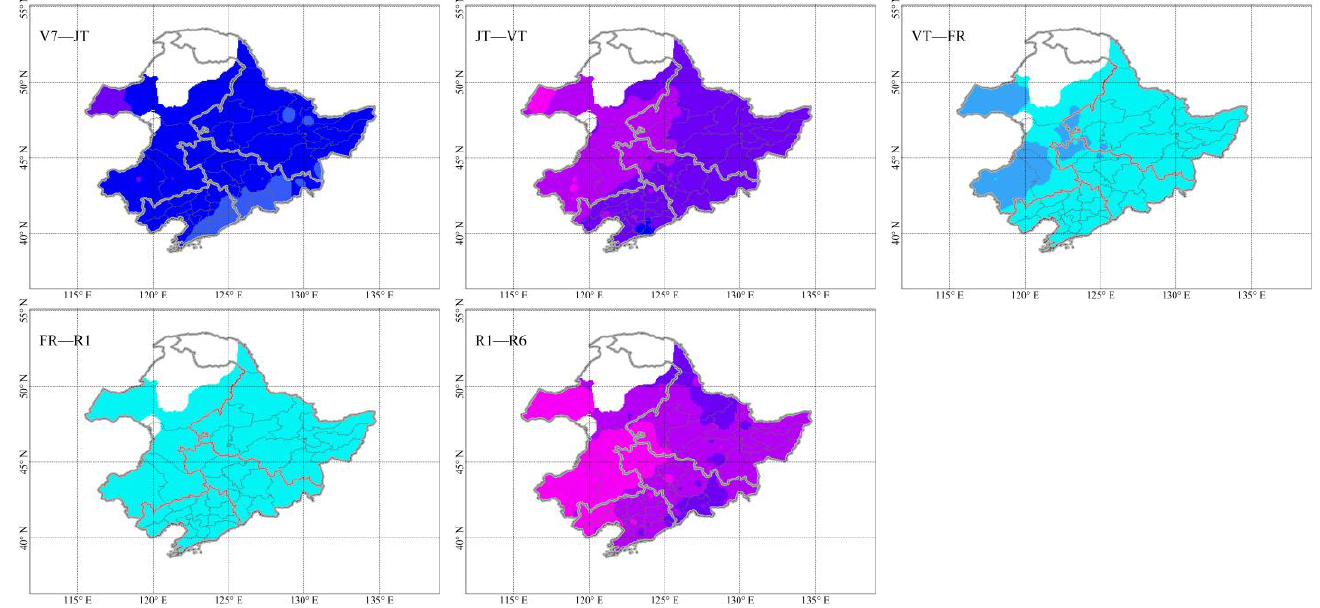
Figure 4. Spatial distribution of total water requirements in different growth stages of maize in Northeast China. NOTE: SW: sowing stage; VE: emergence stage; V3: three-leaf stage; V7: seven-leaf stage; JT: jointing stage; VT: tasseling stage; FR: flowering stage; R1: silking stage; R6: harvesting stage.